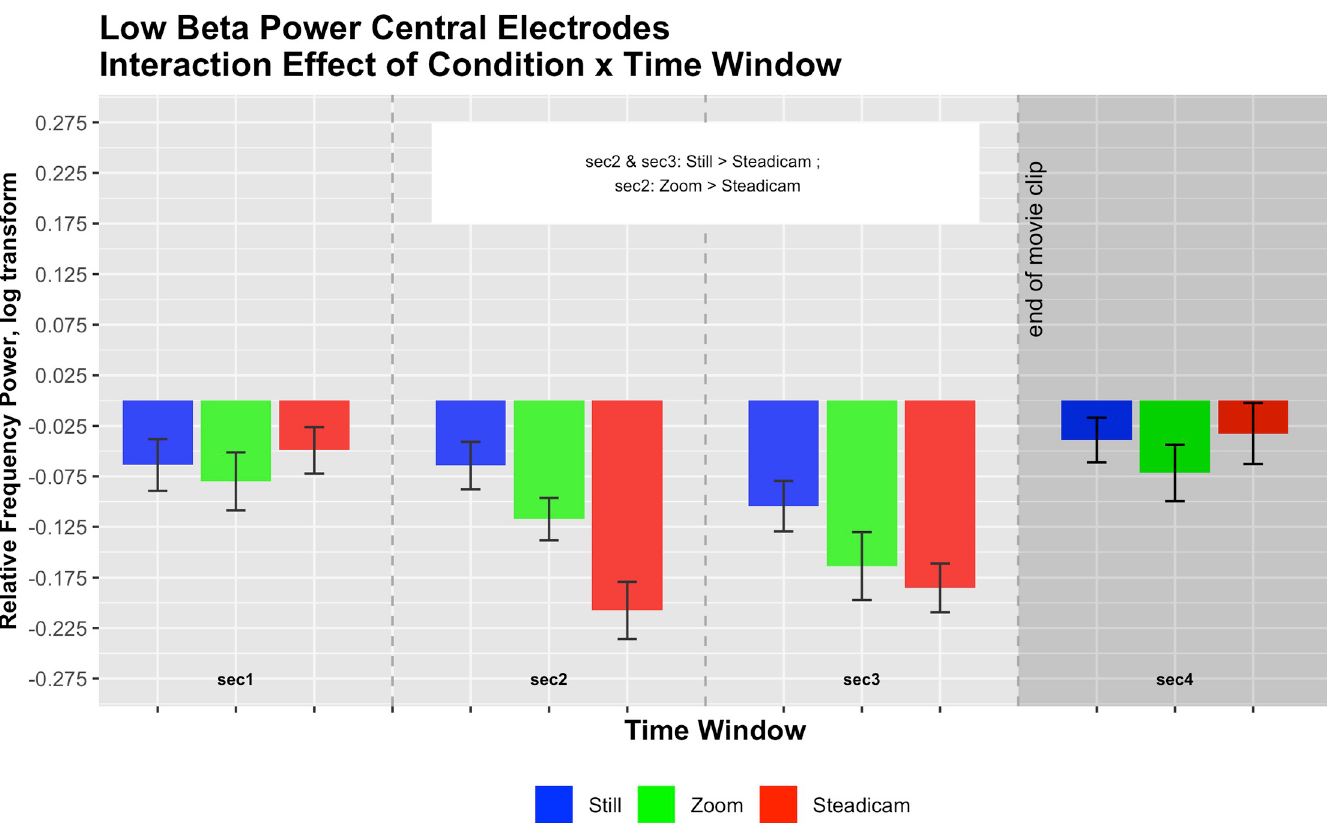
Fig 5. Central low beta frequency power (log corrected for normality) in the three observation conditions across the four time windows. Interaction effect F(6,90) = 5.52, p < 0.001, partial eta squared =